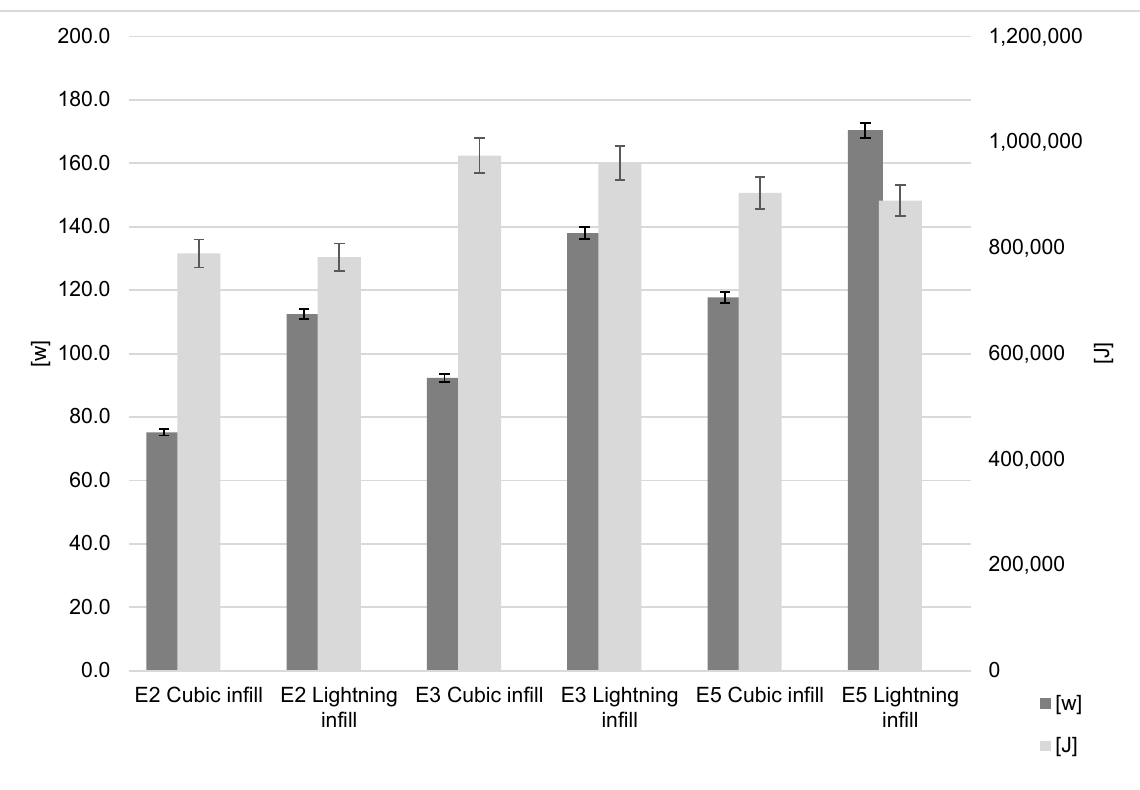
Figure 9. Infill influence on energy results.